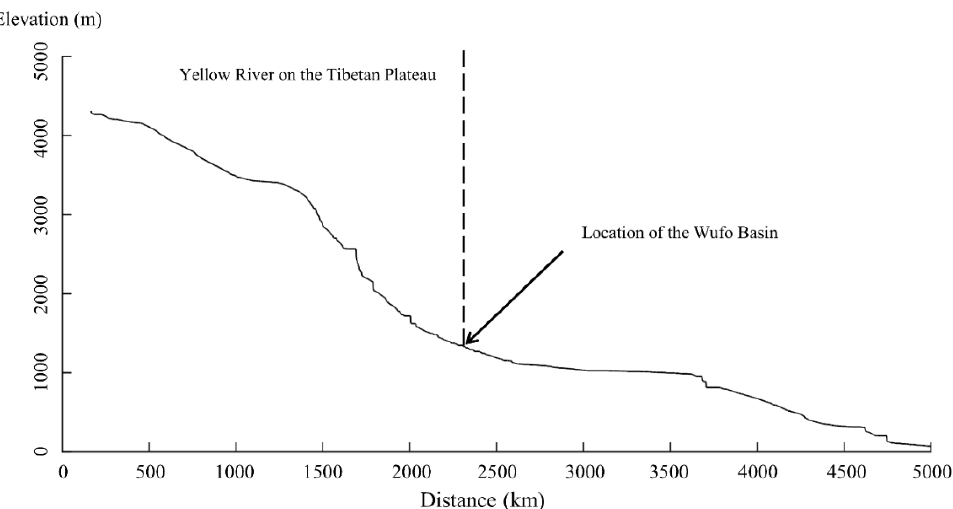
Figure 2. The longitudinal profile of the Yellow River. The black arrow shows the location of the Wufo Basin and the black dotted line shows the northeastern border of the position of the Tibet Plateau.